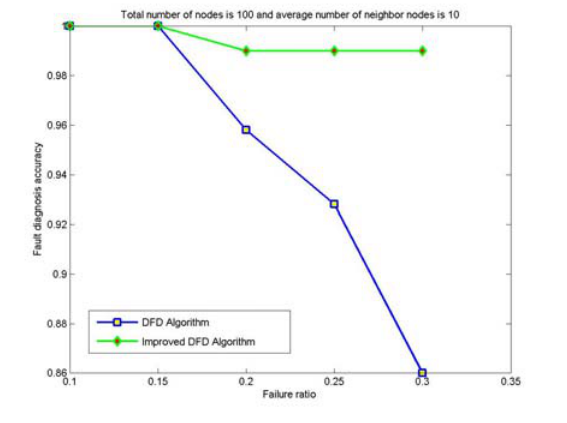
Figure 5. The node fault detection accuracy with various node failure ratios when 100 nodes are randomly deployed and the average numbers of neighbor nodes is 10.